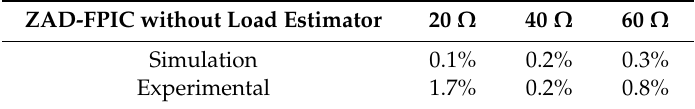
Table 7. Error in the controlled